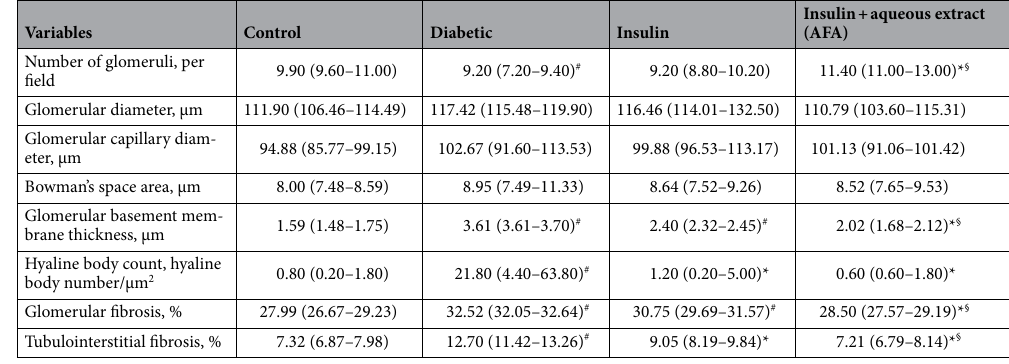
Table 2. Histological analyses of control, diabetic, and treated diabetic groups. Results are expressed as the median (interquartile range). # P < 0.05, vs. control group; *P < 0.05, diabetic group; § P < 0.05, insulin group.